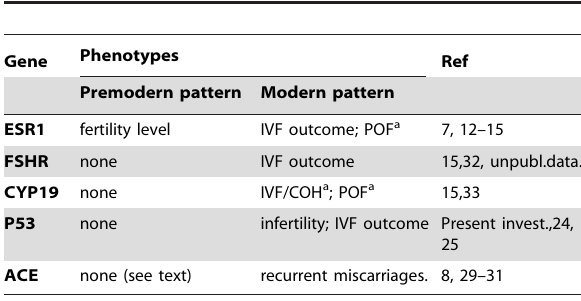
Table 4. Fertility related polymorphic genes which have been investigated for their role in populations with different reproductive